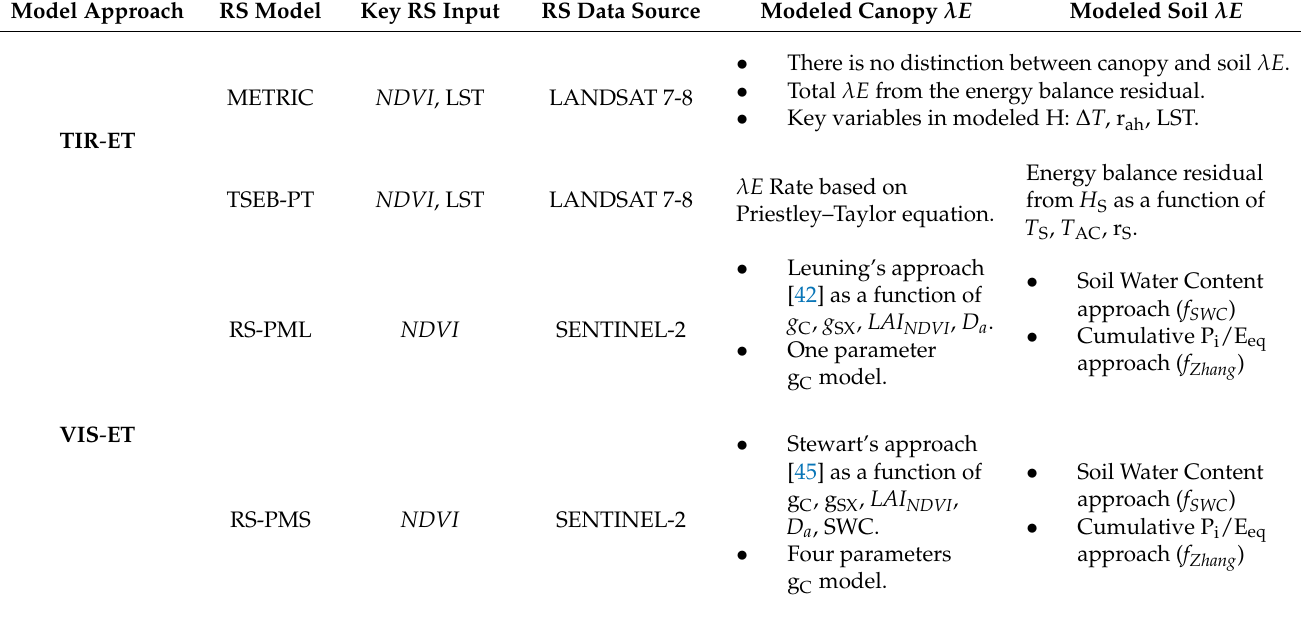
Table 4. Main features of the models Mapping Evapotranspiration at High Resolution with Internalized Calibration (METRIC), Priestley–Taylor Two Source Energy Balance (TSEB-PT), Remote Sensing Penman-Monteith–Leuning (RS-PML) and Remote Sensing Penman-Monteith–Stewart